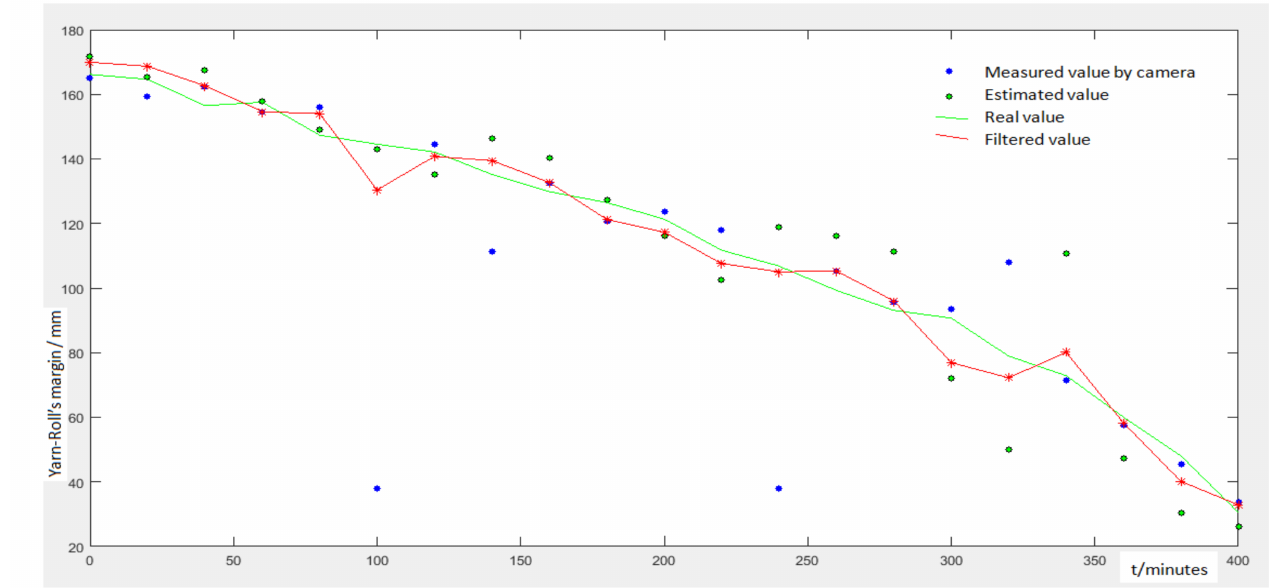
Figure 14. The final results detected in different time. Red line is filtered results, green line is real margin, green points are predicted value, blue points are measured